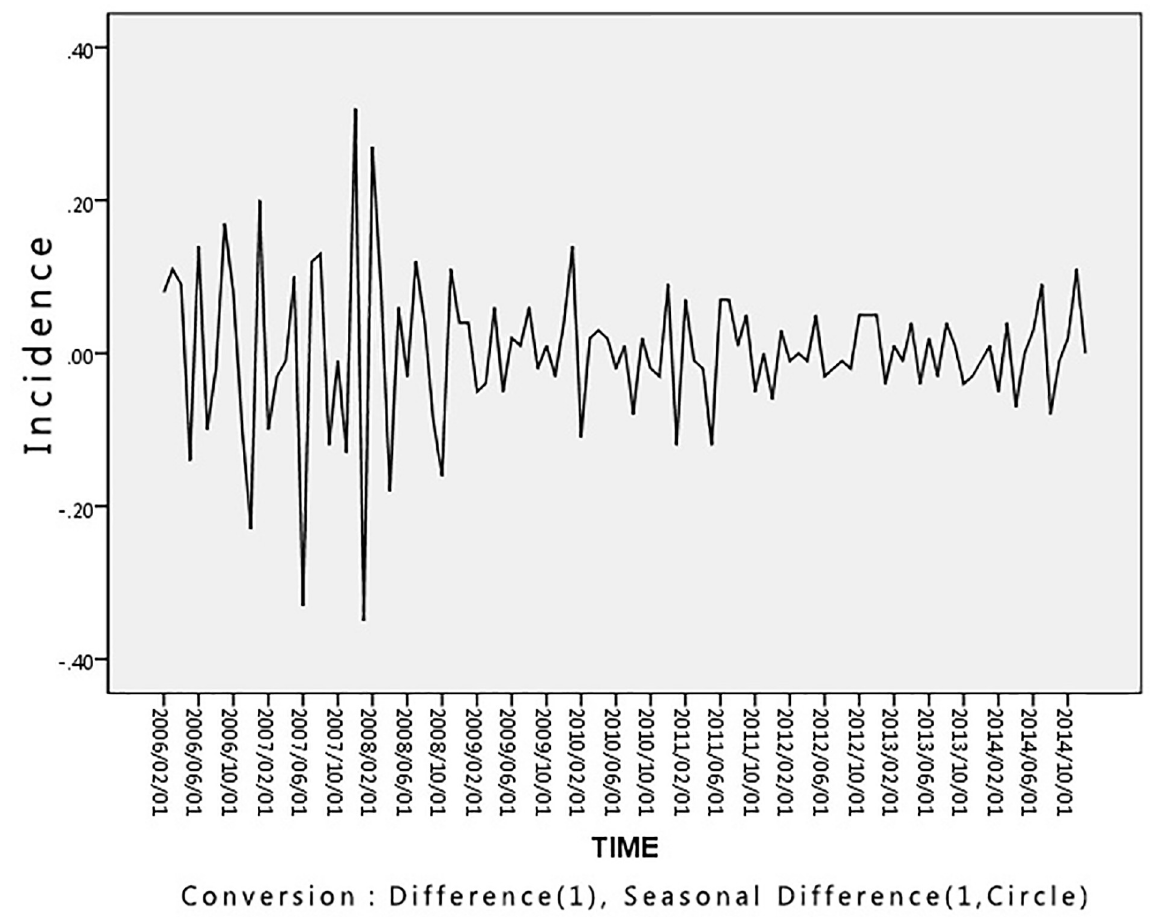
Fig 6. Time series results using first-order difference for the HFRS incidence data. The polyline is constructed using the collected HFRS incidence points after seasonal difference adjustment.